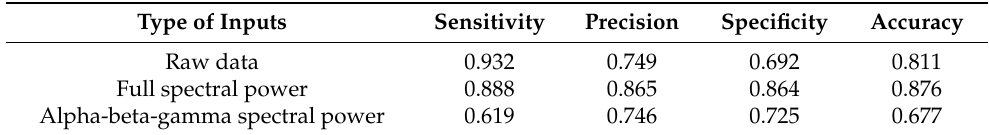
Table 1. Results of three types of input signals.